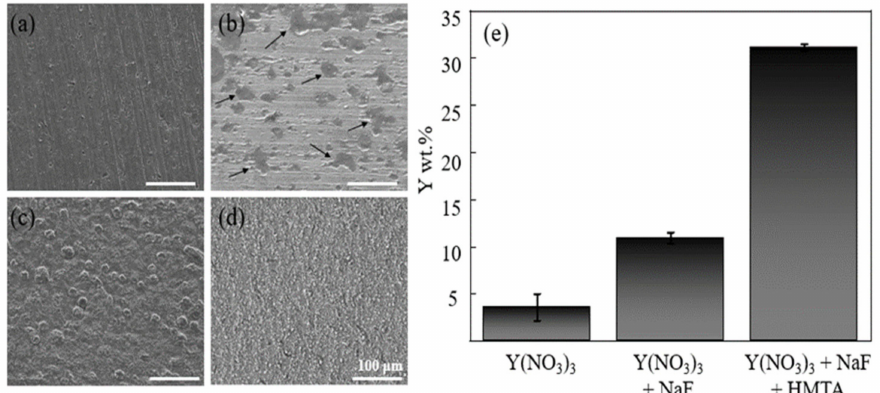
Figure 5. SEM images of the Al substrate ( a ) before and after the LISSC process in ( b ) Y(NO 3 ) 3 , ( c ) a mixture of Y(NO 3 ) 3 and NaF, and ( d ) a mixture of Y(NO 3 ) 3 , NaF, and HMTA solution. ( e ) The quantitative EDS data for the weight percentage of Y component distribution on Al after the coating process, by precursor solution